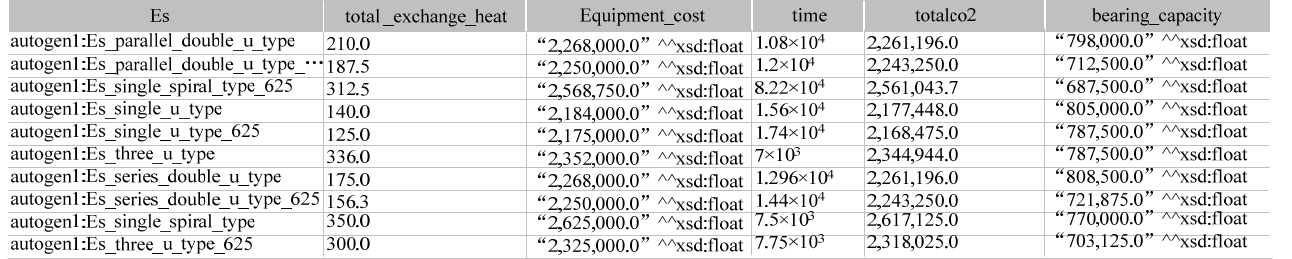
Figure 8. Execution and results of querying R.8 in Table 3.